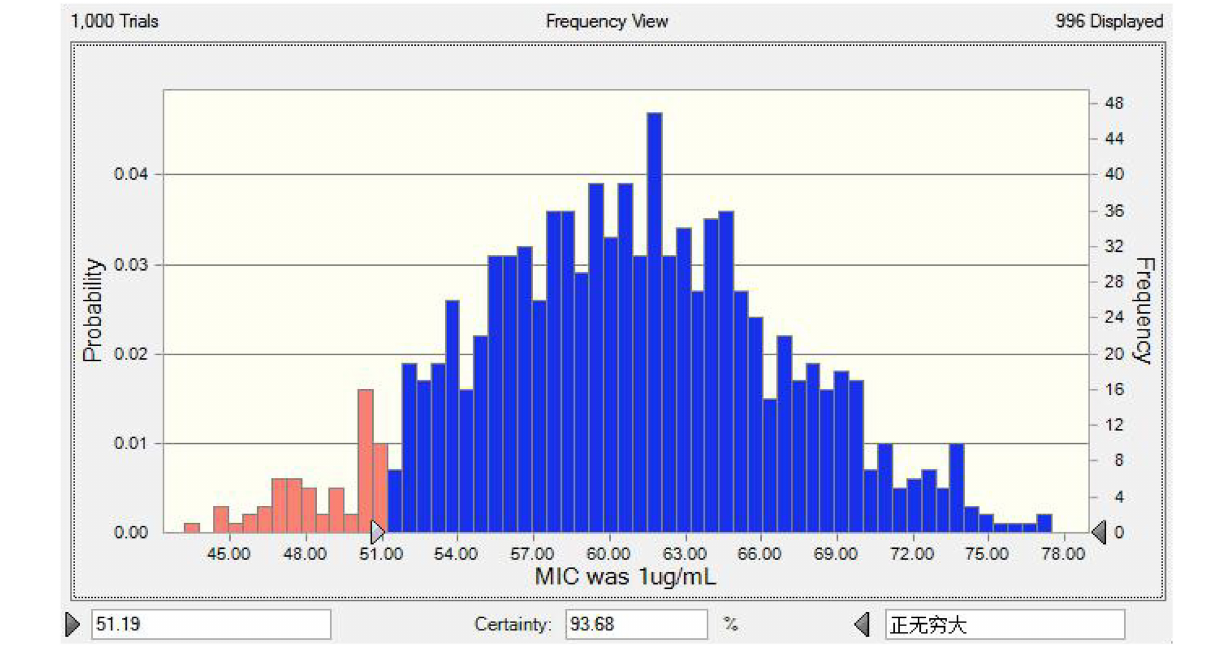
FIGURE 7 | The predicted TAR of tylosin against MG at 1 µ g/mL.